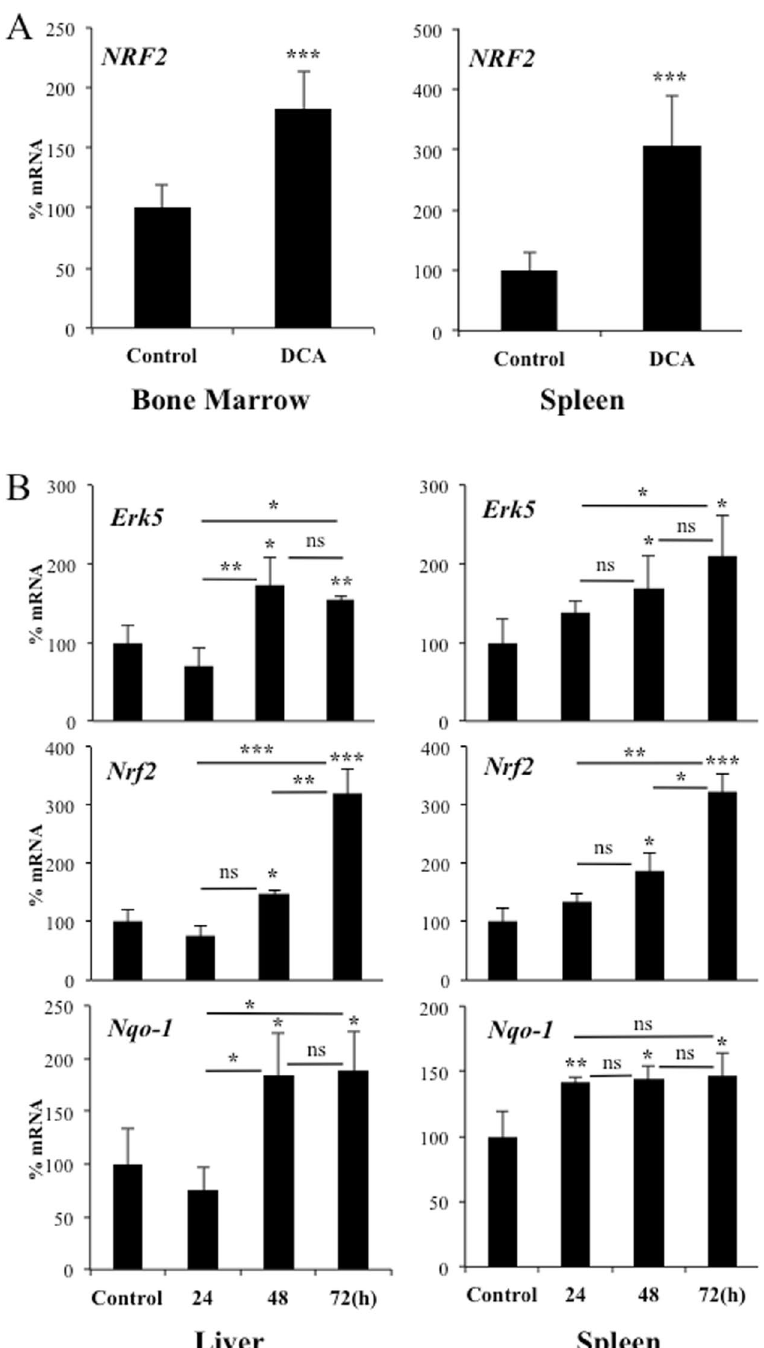
Figure 3. Cells performing OXPHOS induce NRF2 expression in vivo . ( A ) NSG mice were engrafted with primary human AML cells. At day 80 post-graft, they were treated with DCA (n = 4) or leave untreated (n = 4). At day 140, mRNA from bone marrow or spleen was isolated and the expression of different human mRNA was quantified by qPCR. ( B ) B6 wt mice (n = 4/5 per group) were treated with a dose of DCA (50 mg/kg) everyday intraperitoneally and mouse Erk5 , Nrf2 and Nqo-1 mRNA was analyzed in spleen and liver at different times. The data represent means ± SD; statistics were performed using student t-test ( A ) or One-way ANOVA with post-hoc Tukey test ( B ); * p < 0.05, ** p < 0.01, *** p < 0.001. Different times posttreatment were compared to non-treated mice (control) if not specified in the